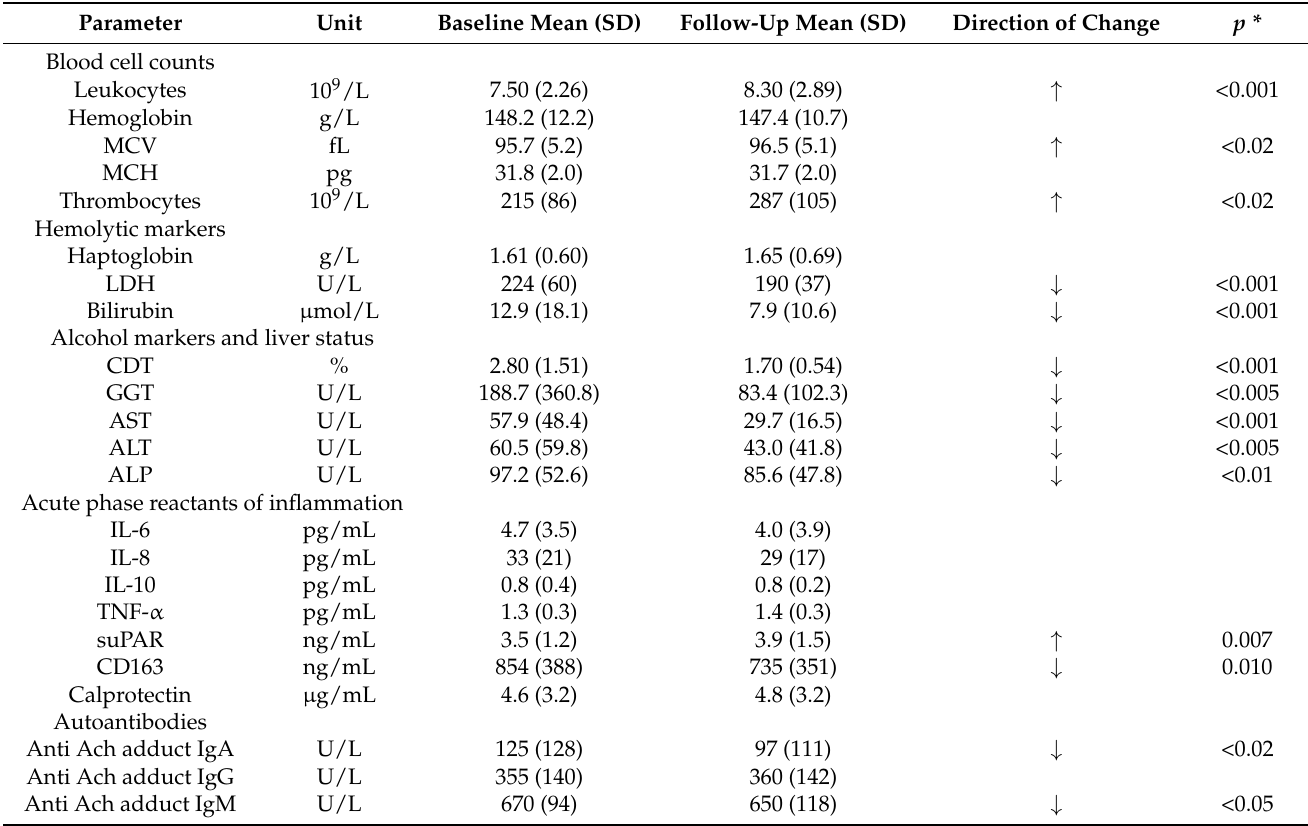
Table 1. Laboratory markers in alcoholics at the time of admission (baseline) and in follow-up samples after 8 ± 1 days of supervised abstinence.